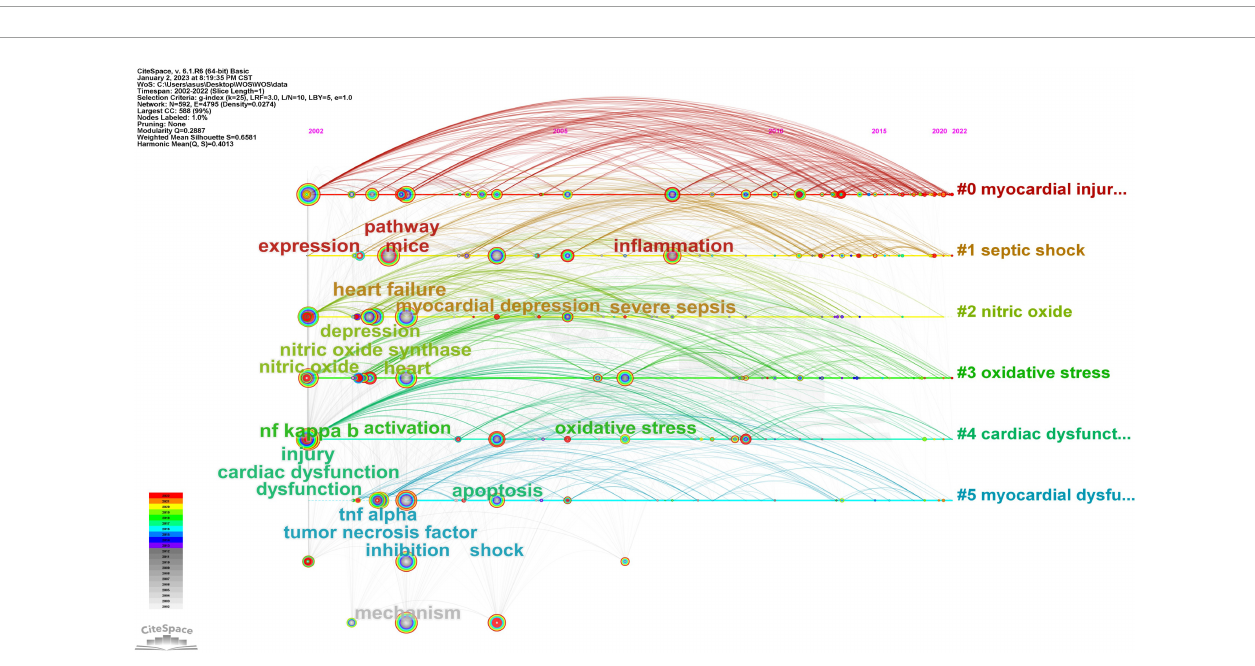
FIGURE9 CiteSpace visualization map of timeline viewer related to SIMD.